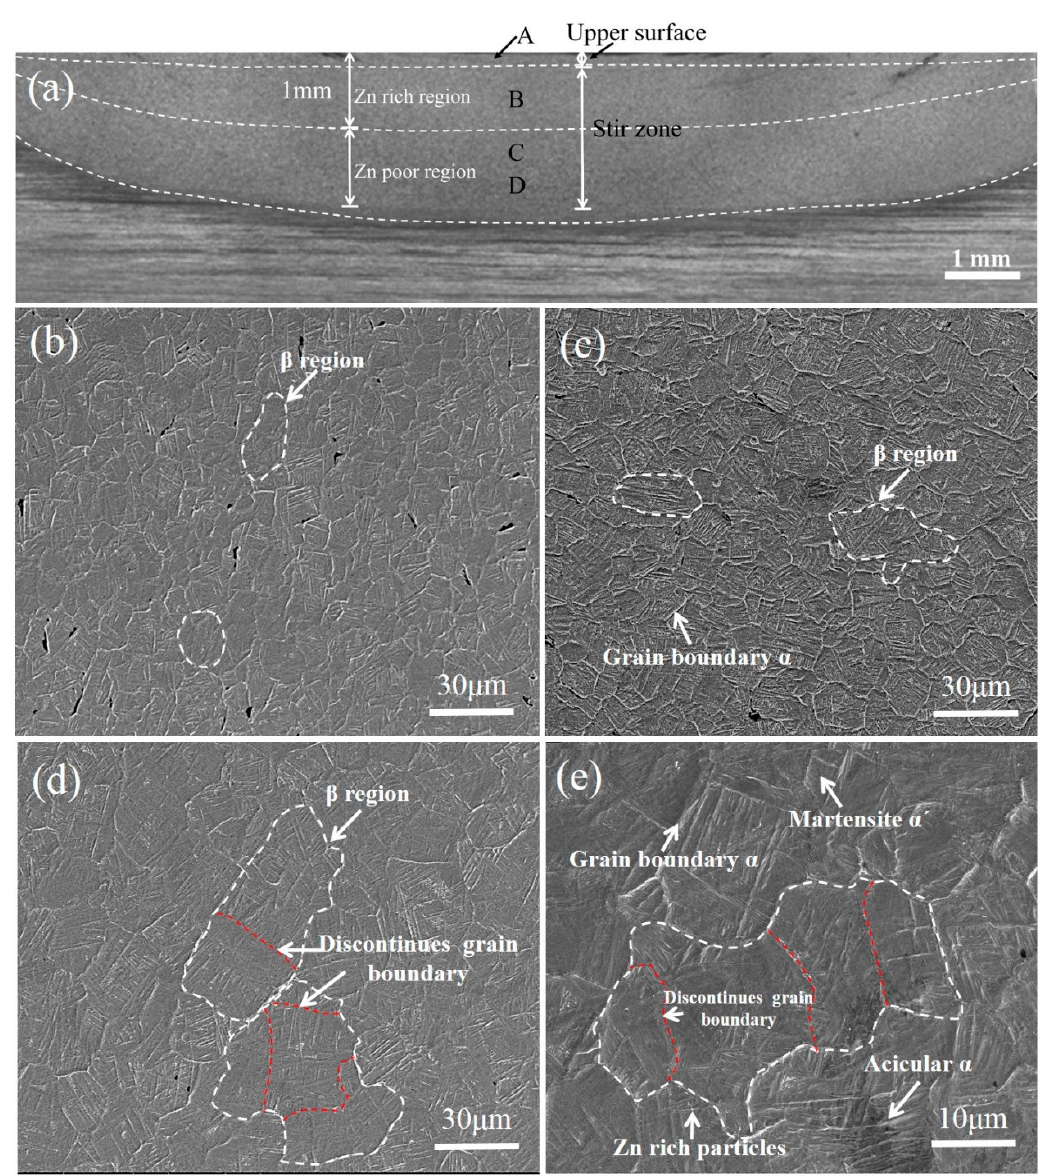
Figure 2. Optical microscopy (OM) and SEM micrographs showing the microstructures of TC4 / Zn composites: ( a ) overview of di ff erent regions at low magnification (OM image). ( b ) FSP225; ( c ) FSP300; ( d ) FSP375 and ( e ) is a magnified version of Figure